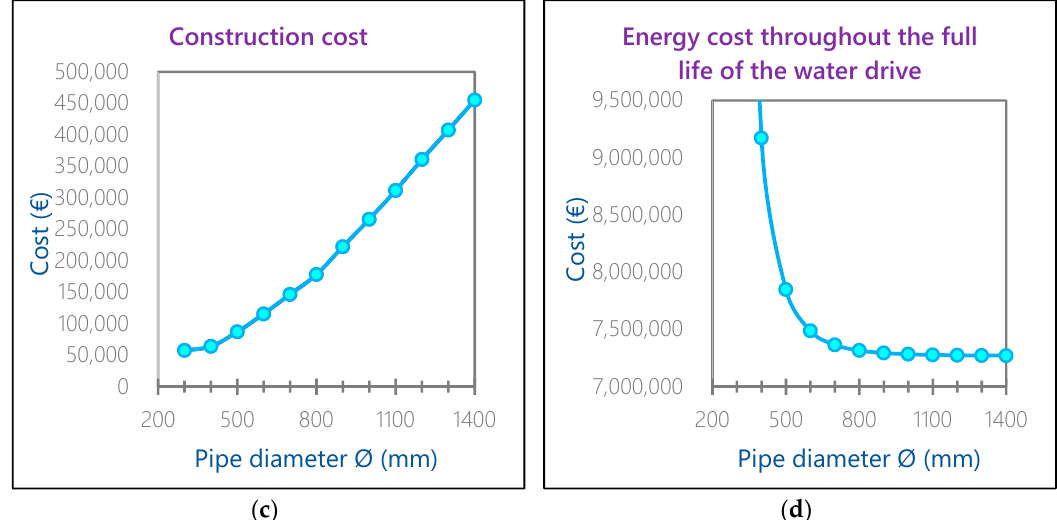
Figure 8. ( a ) Flow rate distribution in the application case of two parallel tubes and ( b ) annual accumulated cost of the energy required for the head losses. ( c ) Construction cost of the installation depending on the pipe diameter. ( d ) Accumulated energy cost throughout the entire lifespan of the installation depending on the pipe diameter.